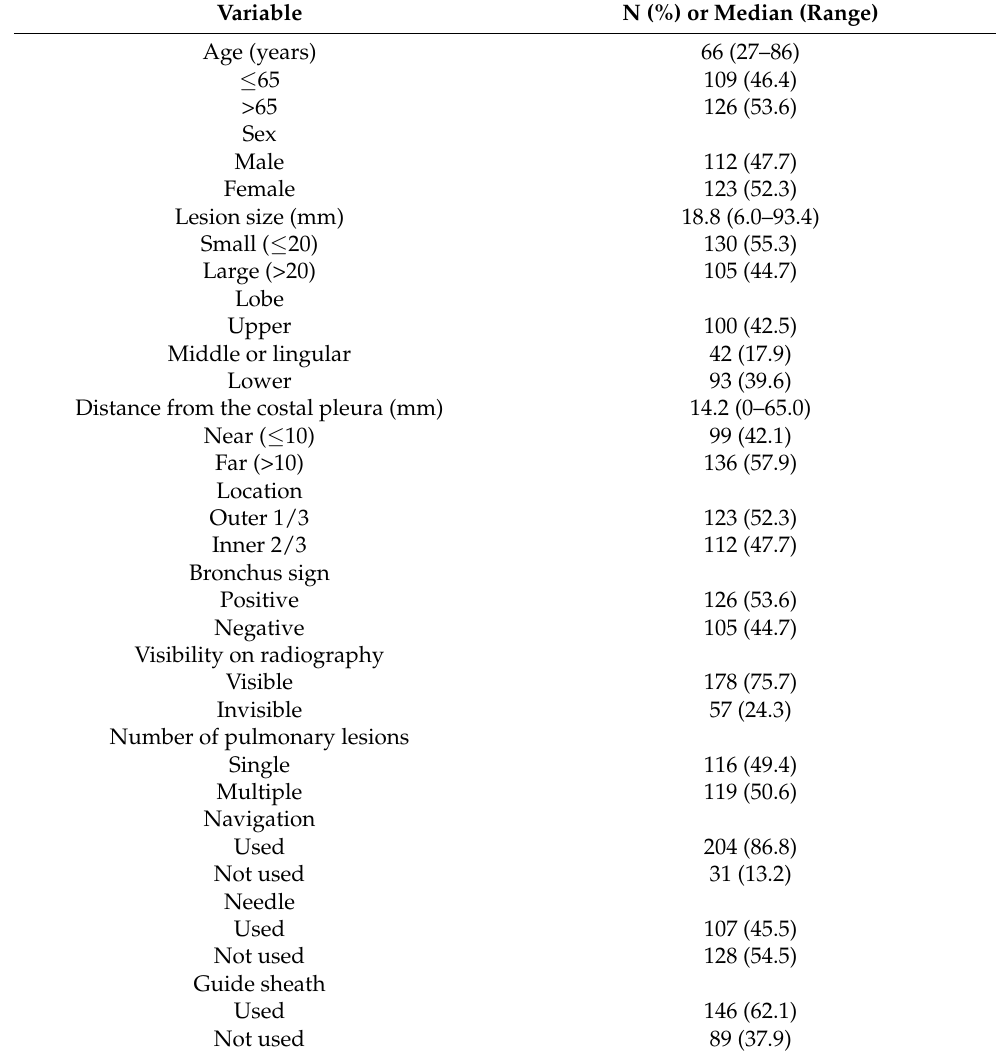
Table 1. Baseline characteristics of